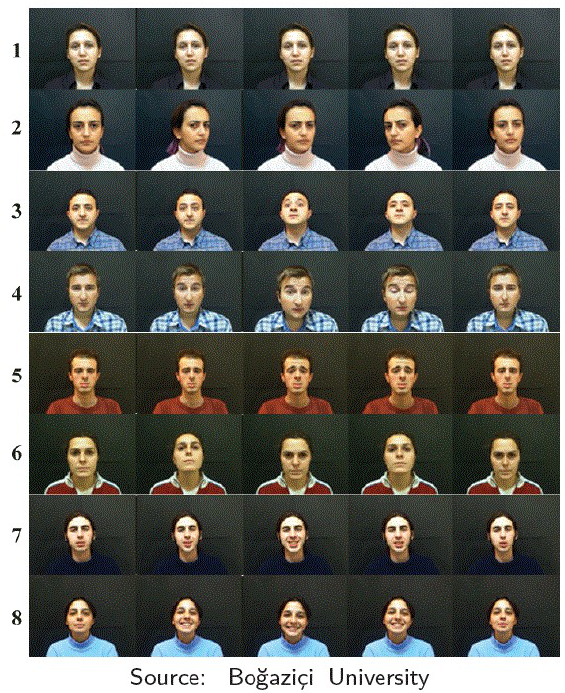
Figure 1. Example of FE classes in BUHMAP dataset. Rows from top to bottom: 1—Neutral, 2—Head L-R, 3—Head Up, 4—Head F, 5—Sadness, 6—Head U-D, 7—Happiness, 8—Happy